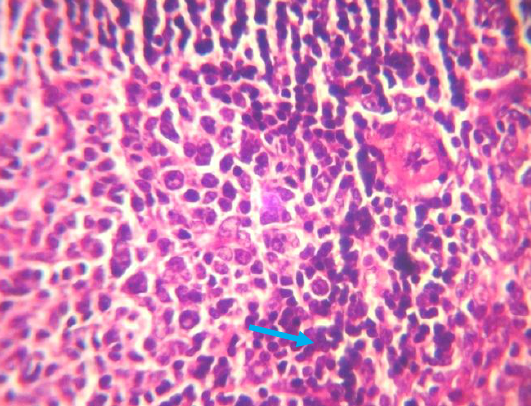
Fig 18: Microscopic lesion of spleen from 2nd immunized group at 20 post at 20 days post challenge show lymphoid hyperplasia in the periarteriolar sheath (H&E